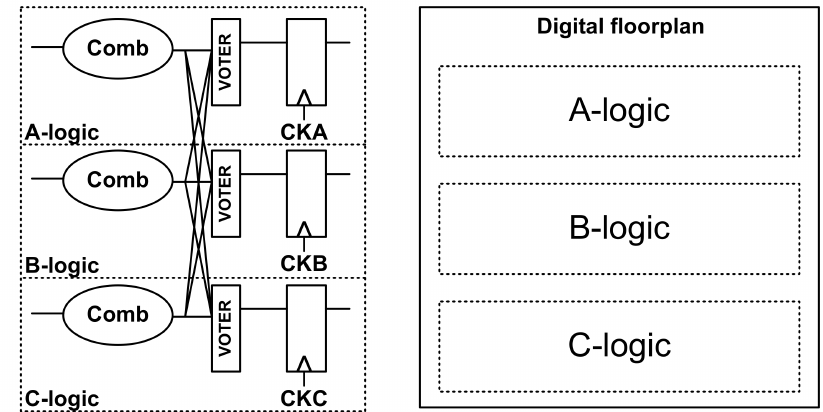
Figure 1. Full TMR design with correcting voters and its associated physical